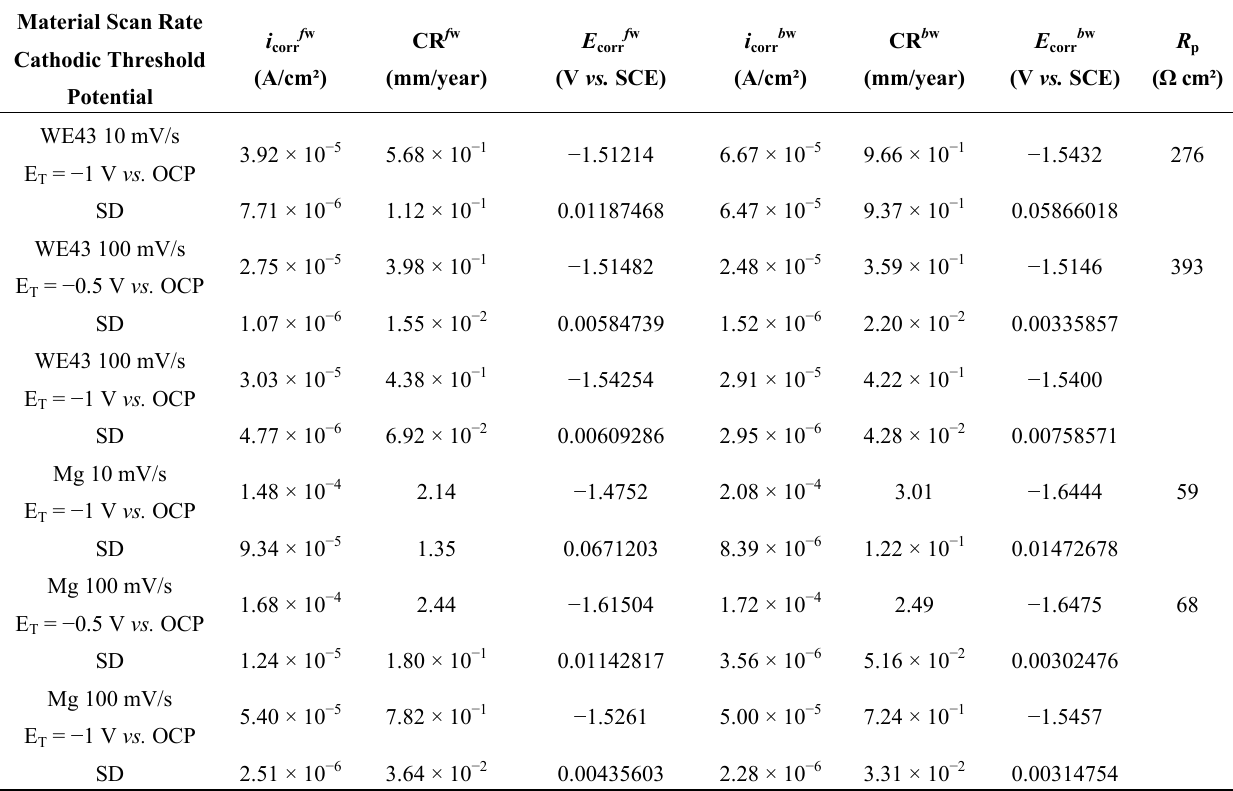
Table 2. Calculated mean values of the corrosion rates (CR) of Mg and WE43 based on I vs. E curves with different scan rates in Ringer